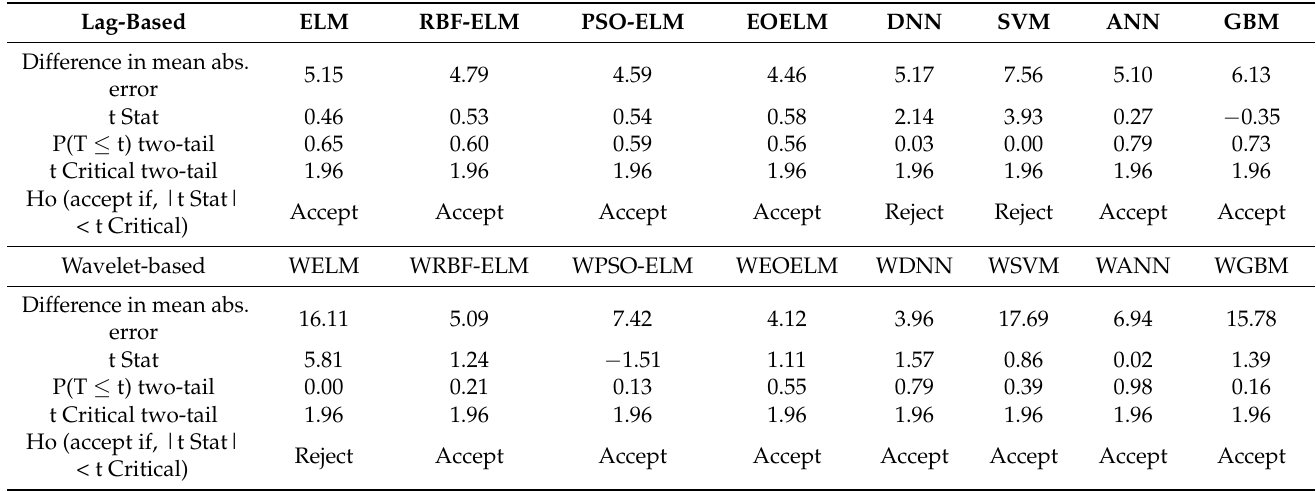
Table 8. Two-tailed t -test for comparing models’ performance for Teifi at